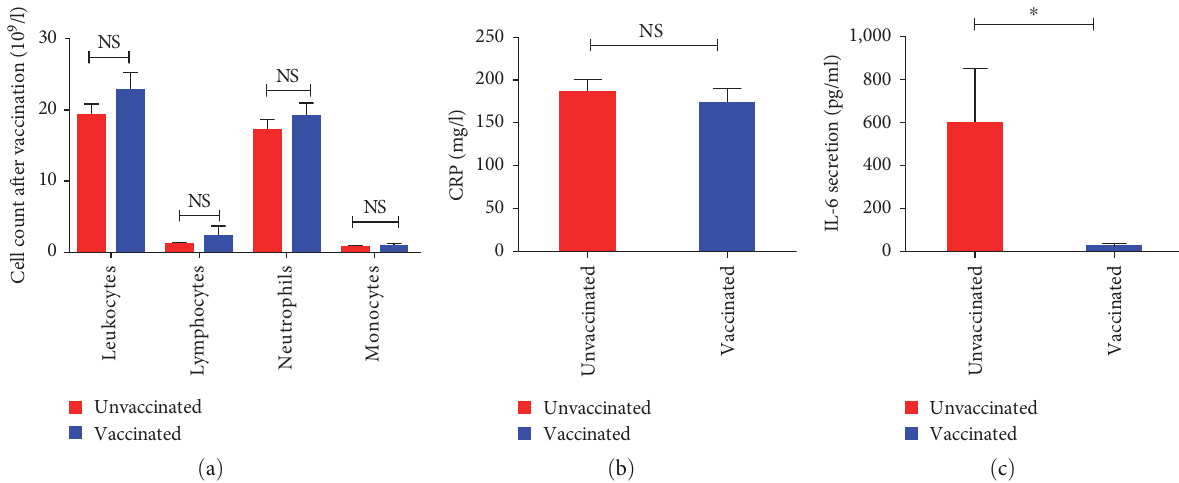
F IGURE 5: Immune cell count and in fl ammatory parameters in peripheral blood following vaccination in all studied groups: (a) no signi fi cant difference was detected following vaccination; (b) CRP level; (c) IL-6 secretion in unvaccinated and vaccinated patients. ∗ p < 0 : 05, NS, no signi fi cant.